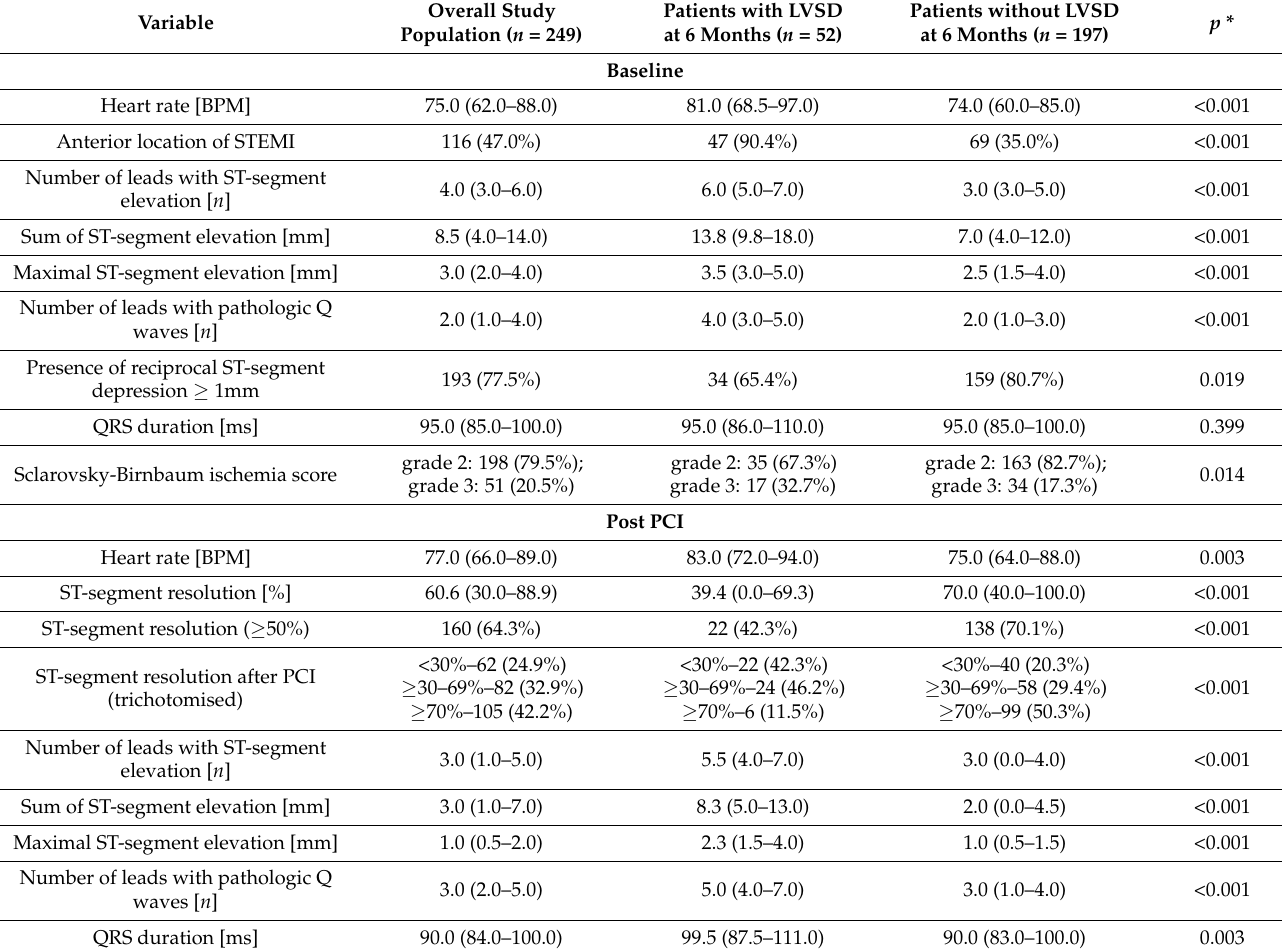
Table 4. Electrocardiographic characteristics of the study population in relation to LVSD occurrence. Data are presented as median (lower quartile-upper quartile) or number (percent) when